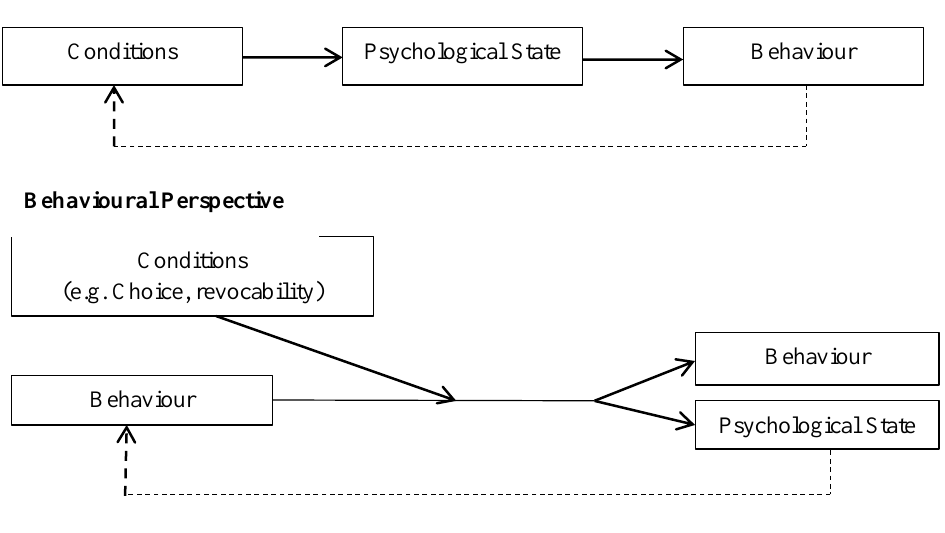
Fig. 1 The Attitudinal and Behavioural Perspectives on Organizational Commitment Source: Adapted from “A Three-Component Conceptualization of Organizational Commitment” by J.P. Meyer & N.J. Allen, 1991, Human Resource Management Review, 1,